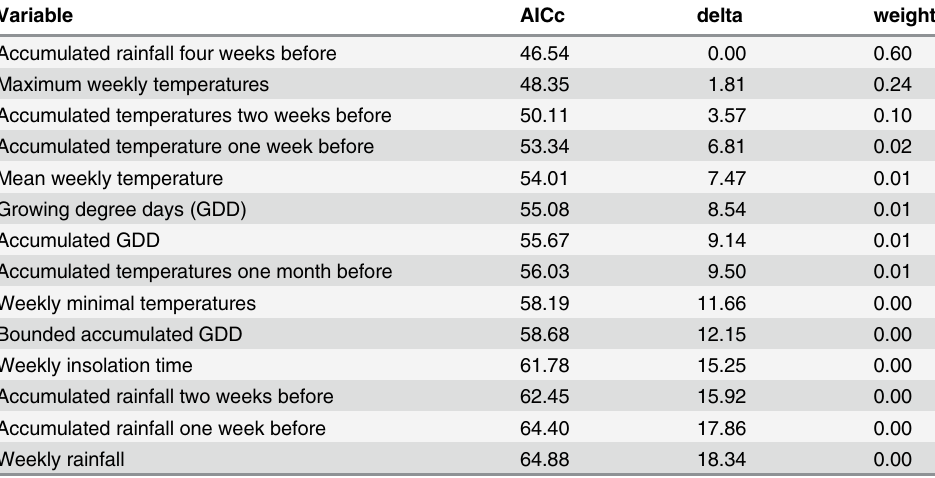
Table 2. Results of the model selection of the Generalized Linear Model with negative binomial distri- bution showing the effect of climatic variables on Ae . albopictus abundances after the inundation in 2014. Variable AICc delta weight Accumulated rainfall four weeks before 46.54 0.00 0.60 Maximum weekly temperatures 48.35 1.81 0.24 Accumulated temperatures two weeks before 50.11 3.57 0.10 Accumulated temperature one week before 53.34 6.81 0.02 Mean weekly temperature 54.01 7.47 0.01 Growing degree days (GDD) 55.08 8.54 0.01 Accumulated GDD 55.67 9.14 0.01 Accumulated temperatures one month before 56.03 9.50 0.01 Weekly minimal temperatures 58.19 11.66 0.00 Bounded accumulated GDD 58.68 12.15 0.00 Weekly insolation time 61.78 15.25 0.00 Accumulated rainfall two weeks before 62.45 15.92 0.00 Accumulated rainfall one week before 64.40 17.86 0.00 Weekly rainfall 64.88 18.34 0.00 The best model explains 92.3% of the